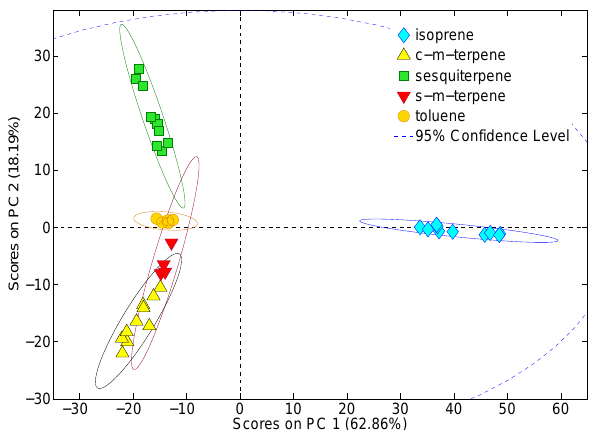
Figure 4. PCA scores plot of the second vs. first principal compo- nents derived from the PCA analysis of the toluene test set using the PCA model derived from the isoprene, cyclic monoterpene ( α - pinene and limonene), sesquiterpene ( β -caryophyllene) and straight chain monoterpene (myrcene and linalool) chamber data. Classifi- cation confidence level is